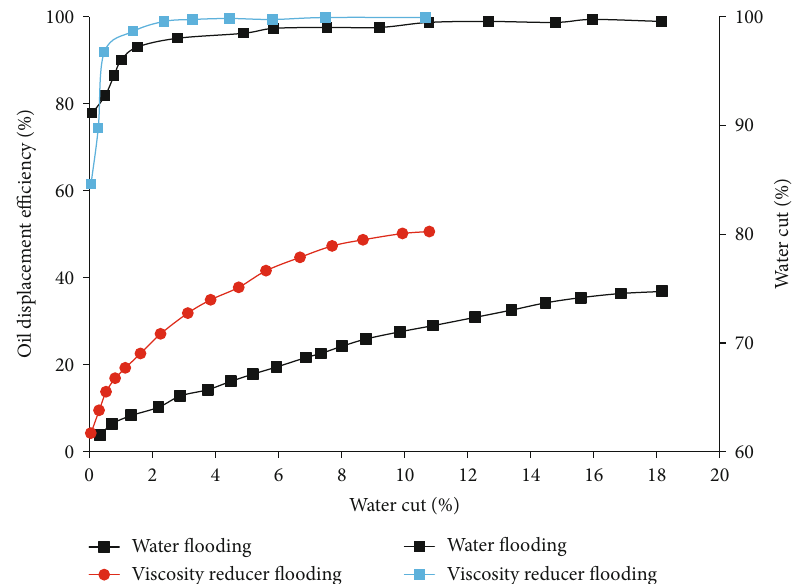
Figure 3: Oil displacement e ffi ciency and water cut curve of sand packs under di ff erent methods.